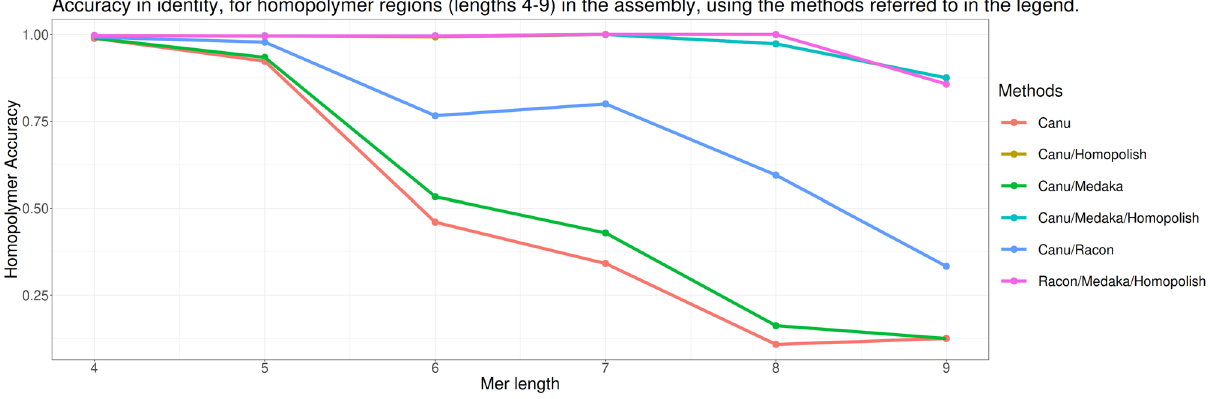
Figure 6. Accuracy of correction of the different polishing tools in combination with Canu for homopolymer sizes between 4 and 9 nt.